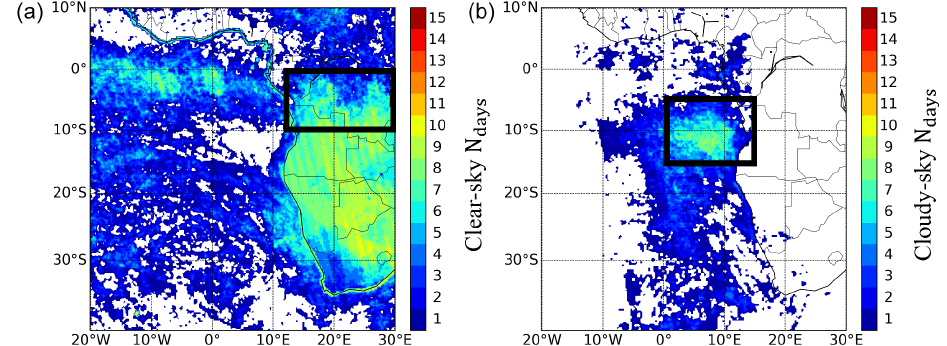
Figure 2. Number of observation days ( N days ) in clear atmosphere (a) and cloudy atmosphere (b) available from the POLDER-3 space sensor during the 1–15 July 2008 period. The black frames indicate the two areas of study of the biomass burning aerosol optical properties in clear sky over land (12–30 ◦ E, 10–0 ◦ S, a ) and above clouds over the southeastern Atlantic Ocean (0–15 ◦ E, 15–5 ◦ S, b ).